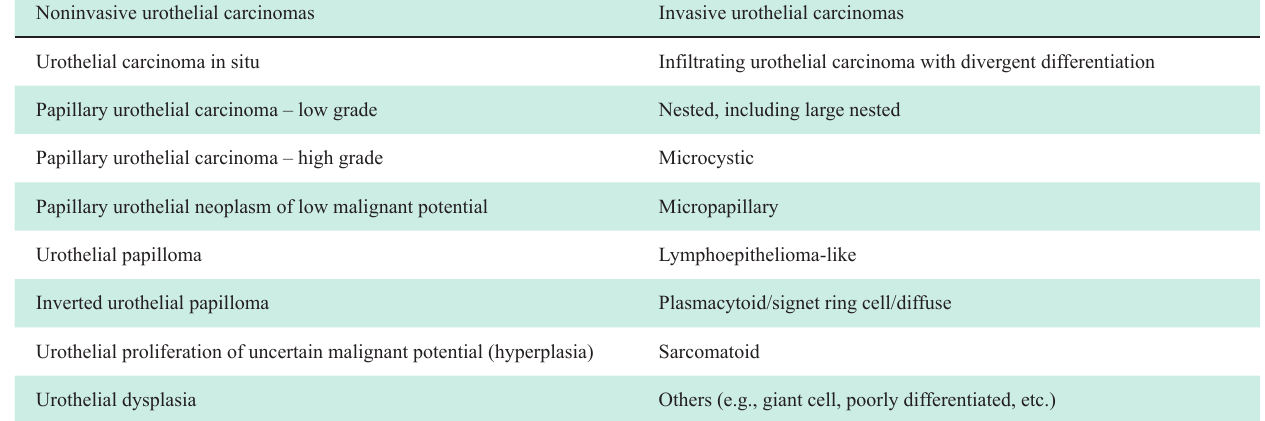
obstruction. Symptoms of advanced urothelial carcinoma Table 1 Noninvasive classifications of urothelial carcinoma 2 Noninvasive urothelial carcinomas Invasive urothelial carcinomas Urothelial carcinoma in situ Infiltrating urothelial carcinoma with divergent differentiation Papillary urothelial carcinoma – low grade Nested, including large